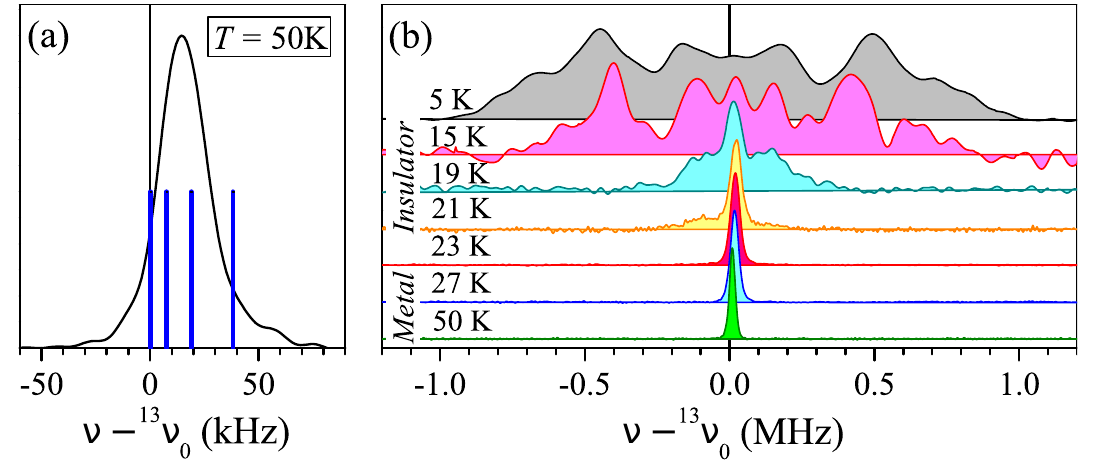
Figure 6. 13 C NMR spectra measured in the external field H = 7 T aligned perpendicular = 74 . 946 MHz. ( a ) The to [0 ¯ 11] at 45 ◦ to ⃗a ∗ . The spectra are shown with respect to 13 ν 0 spectrum at T = 50 K. Blue solid lines indicate positions of the resonance peaks calculated with the shift tensor of κ -(ET) Cu[N(CN) ]Br [15]; ( b ) The evolution of the 13 C NMR 2 2 spectrum with